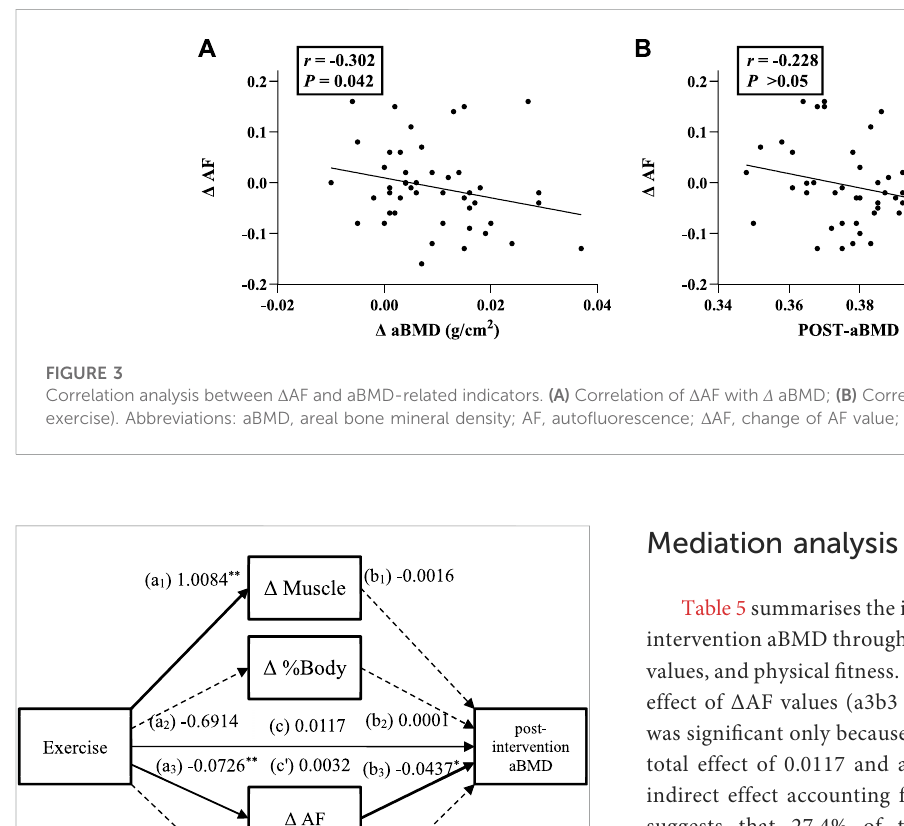
FIGURE 4 Mediated model of the relationship between exercise and post-intervention aBMD. a 1 , a 2 , a 3 , a 4 , b 1 , b 2 , b 3 , b 4 : path coef fi cients from the bootstrap procedure; c: the total effect of exercise on the post-intervention aBMD; c ’ : the indirect effect of exercise on the post-intervention aBMD. The solid paths are signi fi cant ( p < 0.05) and the dashed paths are not signi fi cant ( p > 0.05). The covariates (physical activity, eating behaviour) are not shown on the graph for overall clarity. Abbreviations: aBMD, areal bone mineral density; AF, auto fl uorescence; Δ AF, change of AF value (Figure